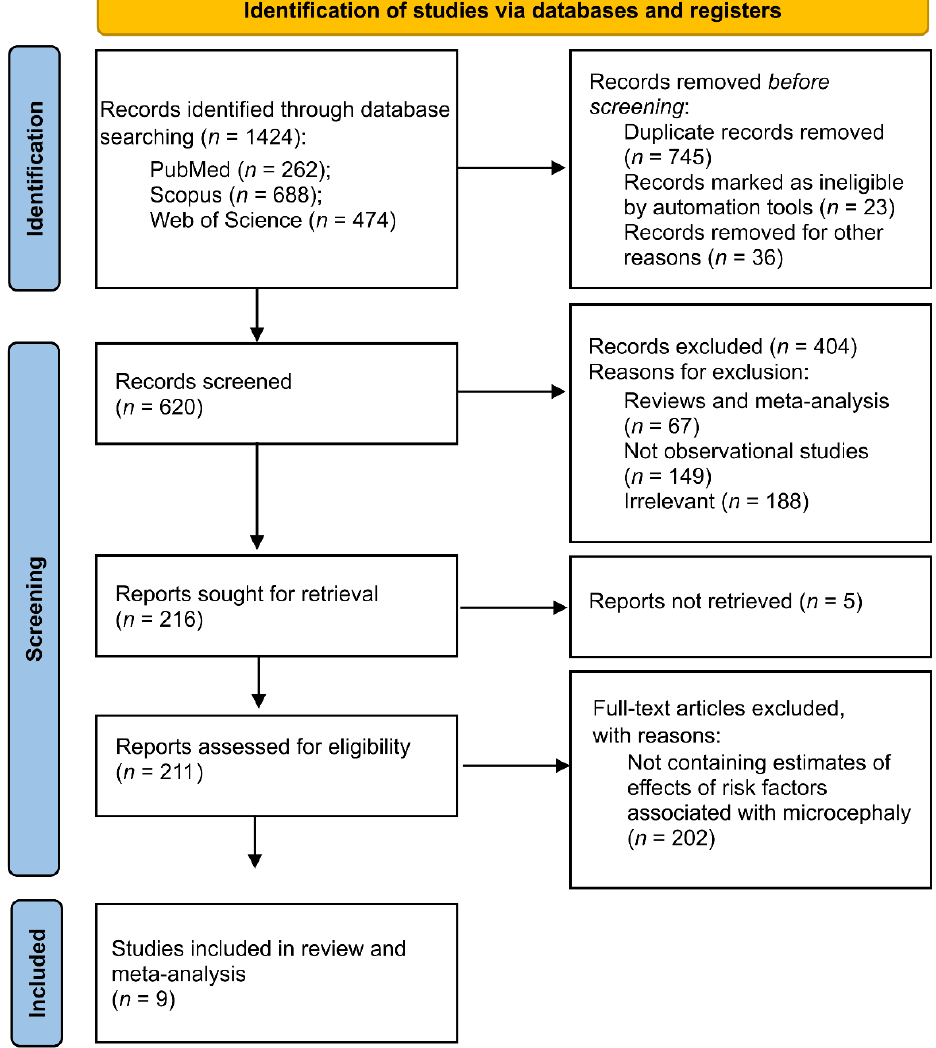
Figure 1. PRISMA 2020 flow diagram for new systematic reviews.